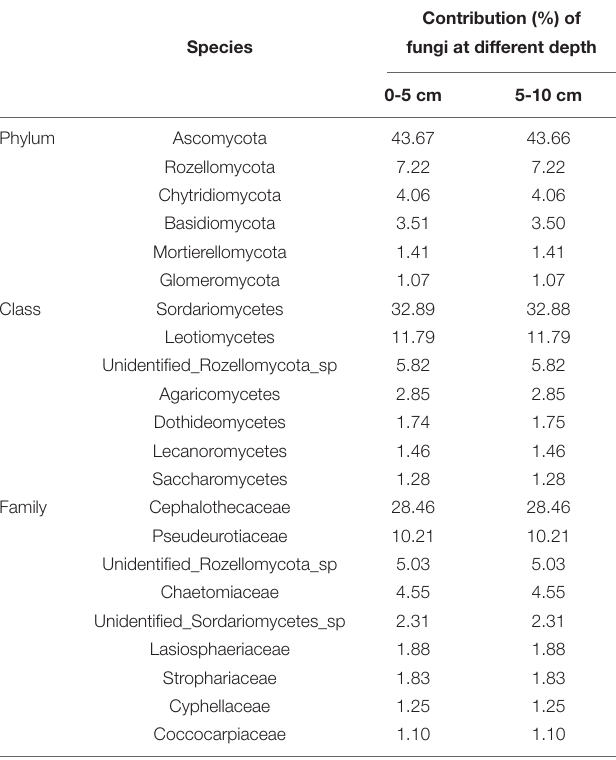
TABLE 3 | The similarity percentage (SIMPER) analysis at phylum, class and family level between FW and